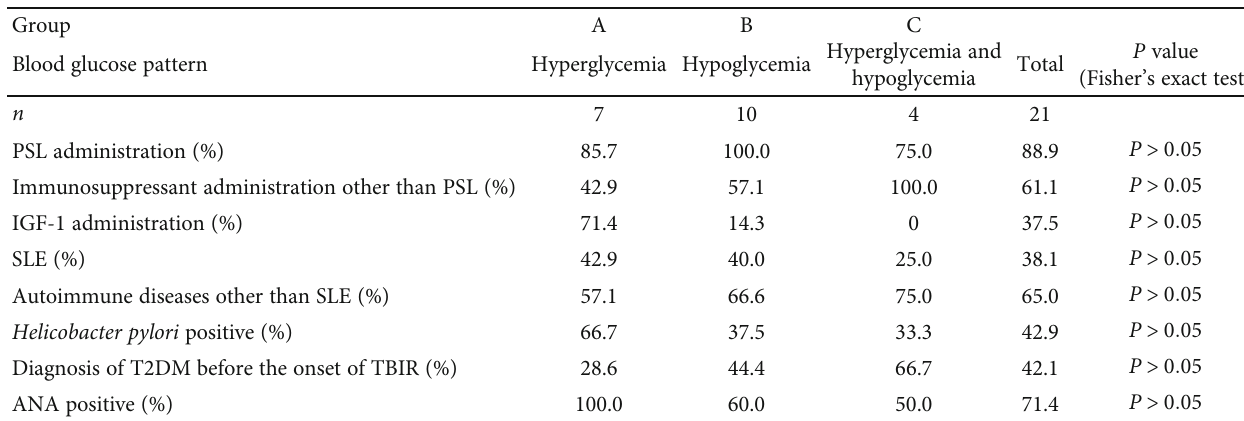
Table 5: Treatment and